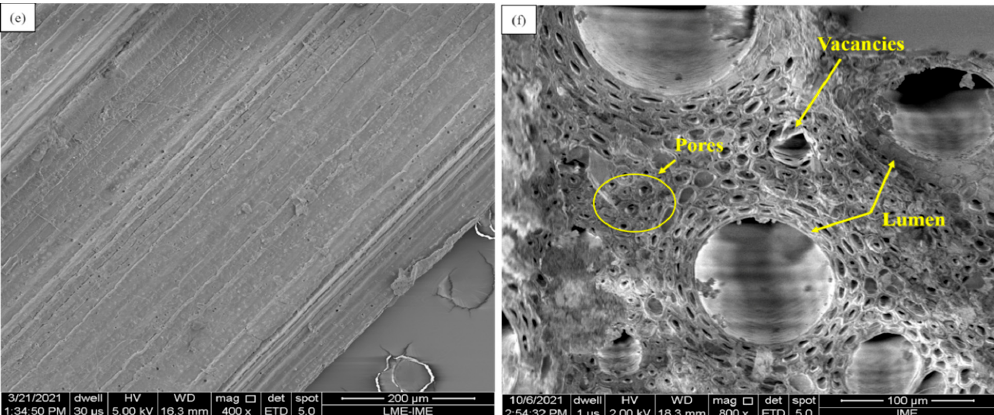
Figure 10. SEM images of the morphological surface of the TVF. ( a ) Longitudinal section of a thin fiber; ( b ) longitudinal section of a thick fiber; ( c , d ) longitudinal section showing defects in the TVF; ( e ) smooth surface and layer of impurities deposited on the fiber surface; ( f ) cross section showing pores, vacancies, and lumens.